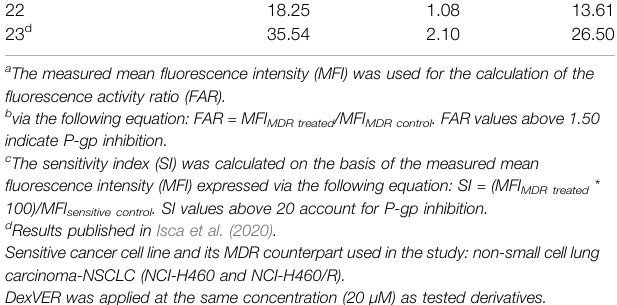
Frontiers in Pharmacology |